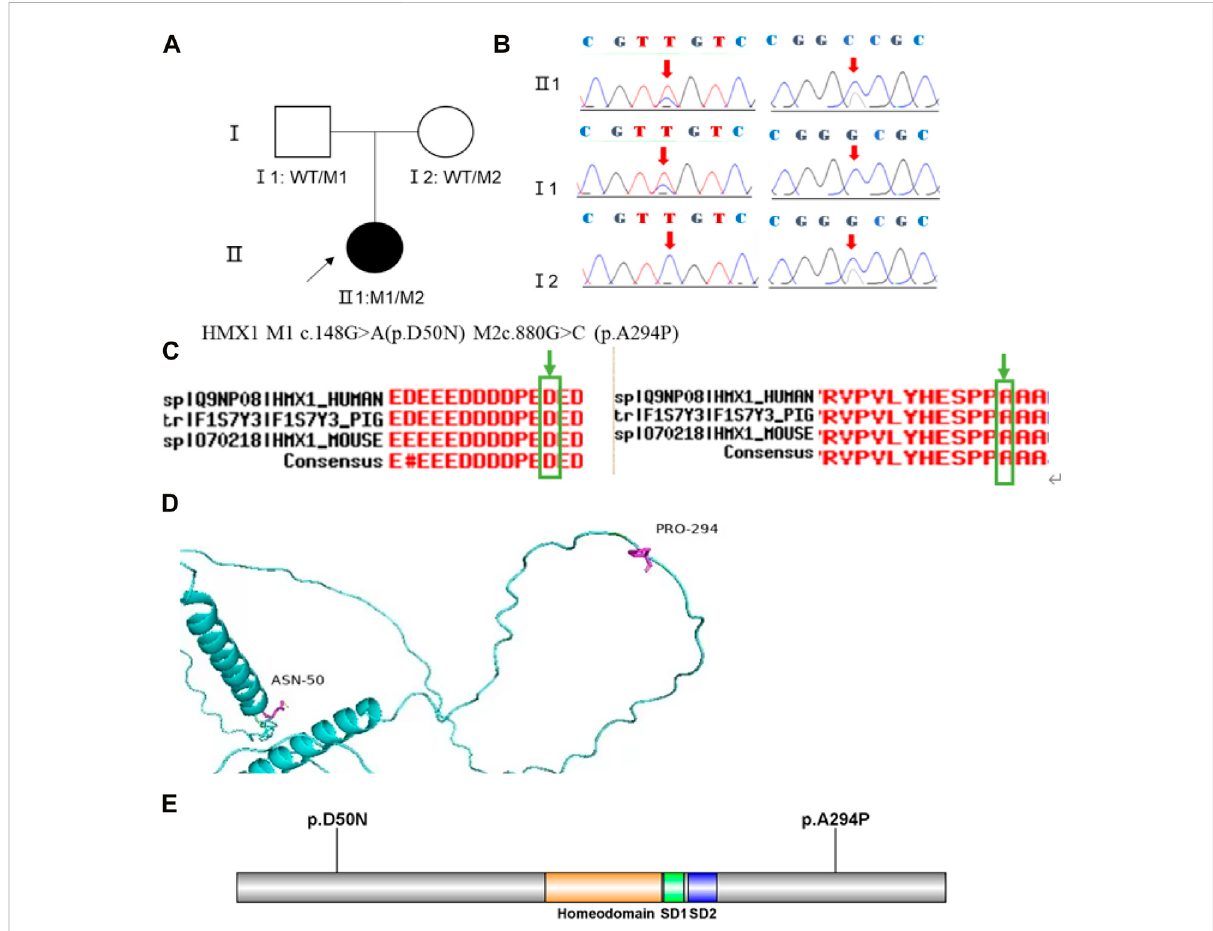
FIGURE 2 Sequence analysis and identi fi cation of the novel variants of HMX1 in the affected Chinese family with autosomal-recessive KC. (A) Pedigree of the family1. The fi lled black symbols represent the affected members, and the arrow denotes the proband. (B) By sequencing analysis, a compound heterozygous variant of (C) 148 G > A and (C) 880G > C were identi fi ed in the affected individual of II:1. (C) The homology of amino acid sequences between human HMX1 and other species. The amino acid at position 50 (Asparticacid, D50) and position 294(Alanine, A294) are highly conserved among species (green box). (D) Homology model of the HMX1 homeodomain (green). Purple indicates the location of p. Asp50Asn and p. Ala294Pro in the protein structure. (E) Structural modelling of HMX1